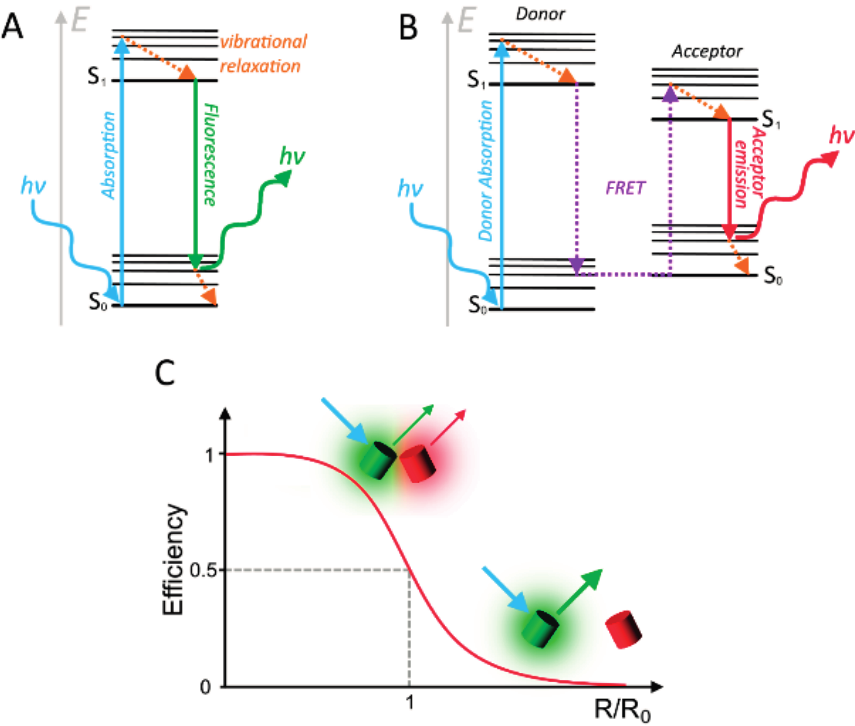
Figure 1. The basic principles of fluorescence and FRET. ( A ) Jablonski diagram, explaining the effect of fluorescence. Absorption of a photon by the fluorophore raises an electron to an excited energy state. Within this state, the electron drops to the ground level via radiationless vibrational relaxation. The excited state is very instable, leading to a relaxation back to the ground state within a few nanoseconds. The energy quantum of this difference is emitted via a photon of a specific wavelength, which is respectively longer than the absorbed wavelength, i.e. , contains less energy; ( B ) Jablonski Diagram explaining the effect of FRET. Here, the energy that is released from the relaxation of the donor is taken up by a suitable acceptor in close proximity, leading to the excitation of one of its electrons, and further to the emission of a photon by the acceptor rather than the donor; ( C ) Correlation between the FRET efficiency and the distance between the fluorophores. The Förster radius R 0 is the distance, where 50% of energy is transferred via